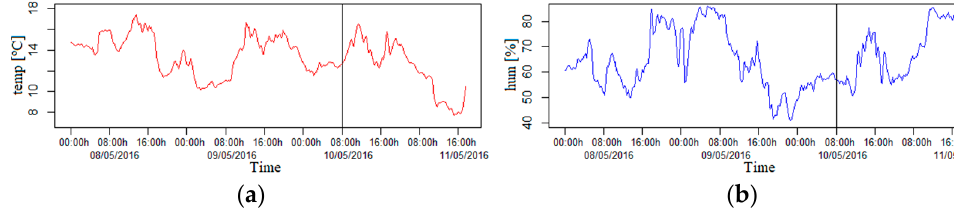
Figure 4. ( a ) The red line corresponds with the evolution over time of the temperature; ( b ) the blue line corresponds with the evolution in time of the humidity. Each vertical line separates the training dataset (on the left) from the test dataset (on the right).